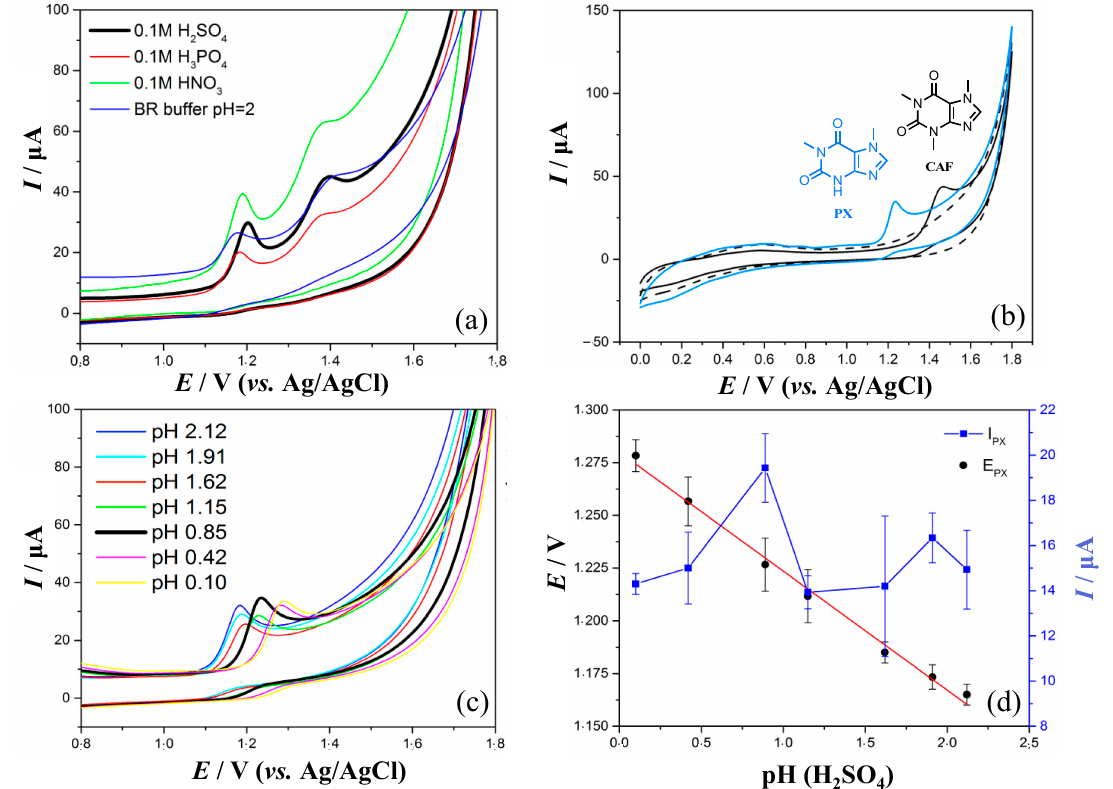
Figure 2. ( a ) Cyclic voltammograms of an equimolar mixture (200 µ M) of paraxanthine (PX) and caffeine (CAF) in the optimal concentration for the various supporting electrolytes on the glassy carbon (GC) electrode with a scan rate of 100 mV s − 1 ; ( b ) cyclic voltammograms of blank 0.1 M H 2 SO 4 (black dashed line), 500 μ M CAF (solid blue line) and 500 μ M PX (solid blue line) in 0.1 M H 2 SO 4 on the GC electrode with a scan rate of 100 mV s − 1 . The chemical structures of the paraxanthine (blue) and caffeine (black) are also given in the figure; ( c ) cyclic voltammograms of 500 μ M PX at various pH values of H 2 SO 4 on the GC electrode with a scan rate of 100 mV s − 1 . The lower lines are the reverse scan of the corresponding upper lines of the same color; ( d ) the effect of pH on the peak potential ( E ) and peak current ( I ) of PX.